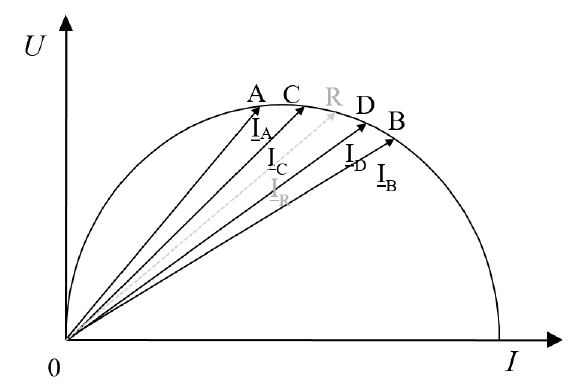
Figure 11. Circular chart for four levels of furnace current changes.